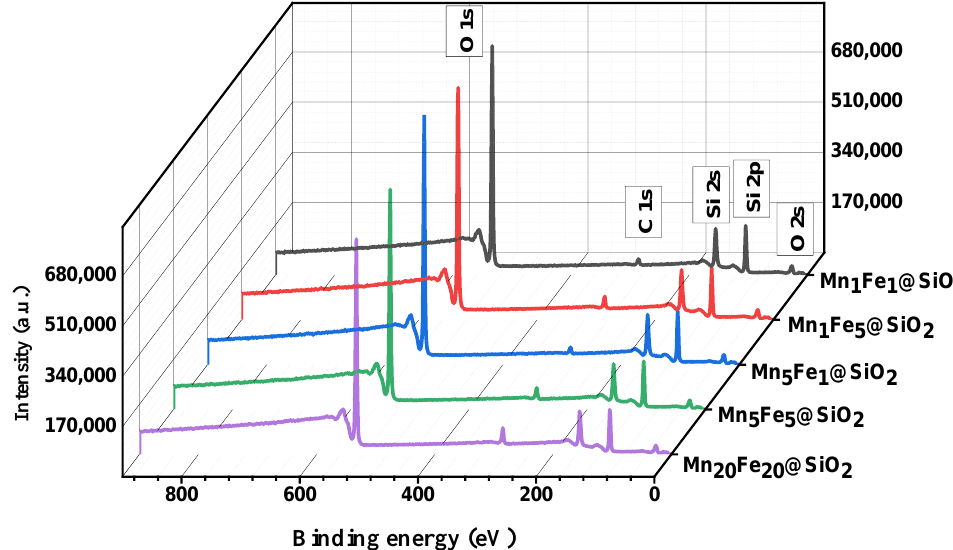
Figure 5. HRXPS Full spectrum of nanocomposites.